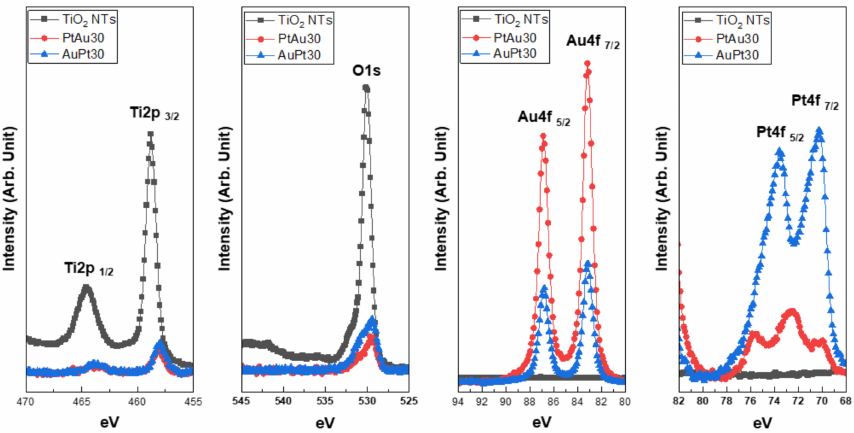
Figure 4. Ti 2p, O 1s, Au 4f, and Pt 4f XPS spectra of Au and Pt multi-coated TiO 2 nanotubes.